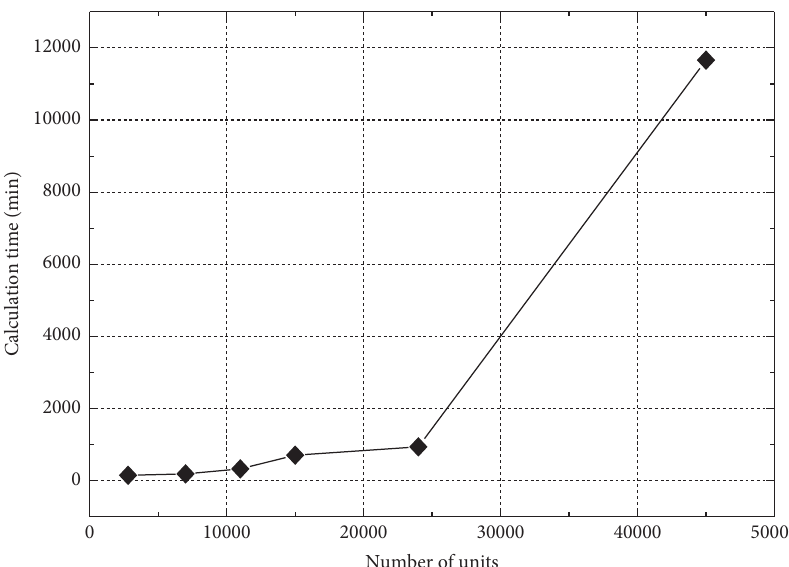
Figure 16: Calculation time of coal sample with different particle numbers.